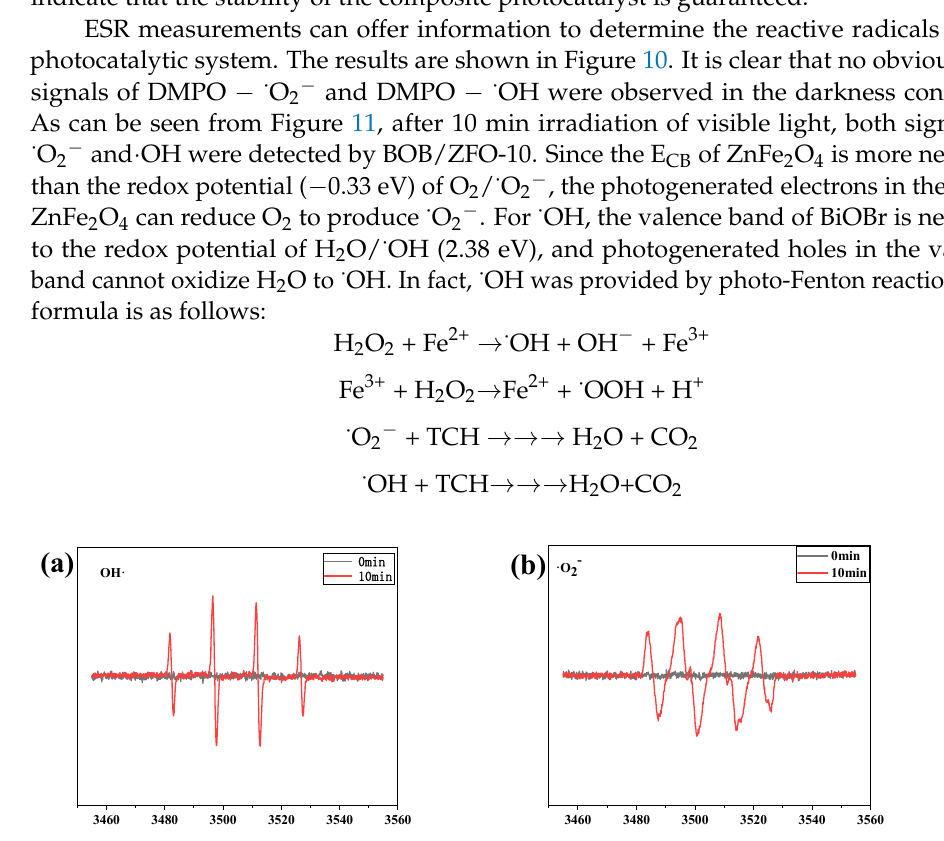
Figure 11. ( a ) The proposed different transportation route of photogenerated charges over pure BiOBr and BOB/ZFO composite (in which the BiOBr is epitaxial grown); ( b ) The band structure